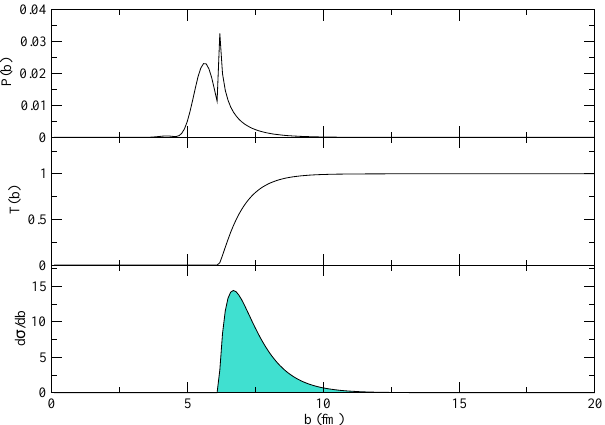
Figure 4. Transfer probability, transmission factor and the resulting differential cross-section ( d σ / db ) are displayed as a function of the impact parameter b for a typical case. Small changes in the imaginary potential affect the transmission factor T ( b ) and consequently the cross-section profile of the lower panel. The present simplified example does not refer to the case discussed in Section